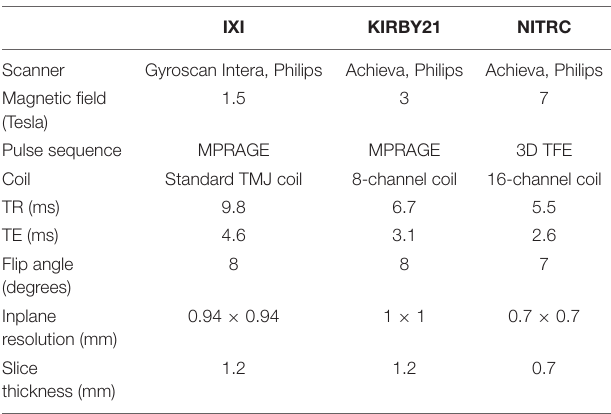
TABLE 1 | Real data: magnetic resonance (MR) imaging sequence